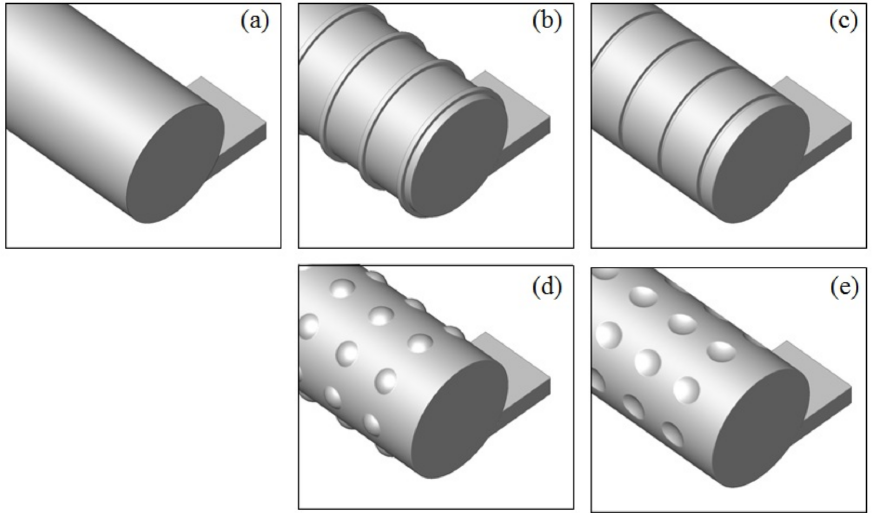
Figure 3. Swirl tube with surface structures on the internal wall: ( a ) Smooth tube; ( b ) Trench tube; ( c ) Rib tube; ( d ) Dimple tube; ( e ) Bulge